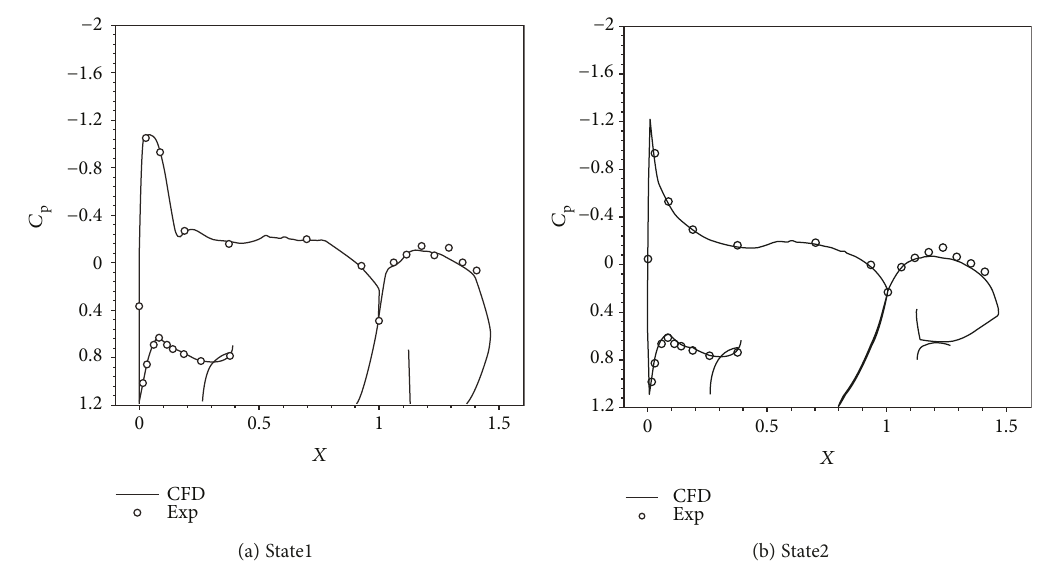
Figure 5: NAL-AERO-02-01 pressure coe ffi cient results of the CFD calculation and TPS test.